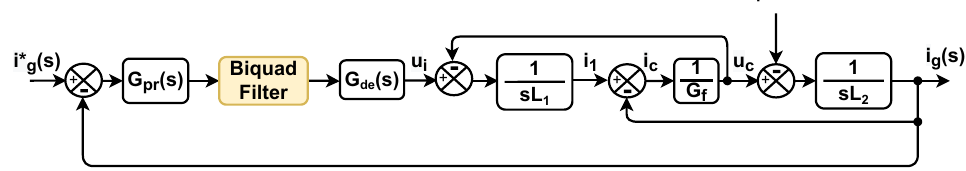
Figure 22. Control block diagram of the biquad filter–based